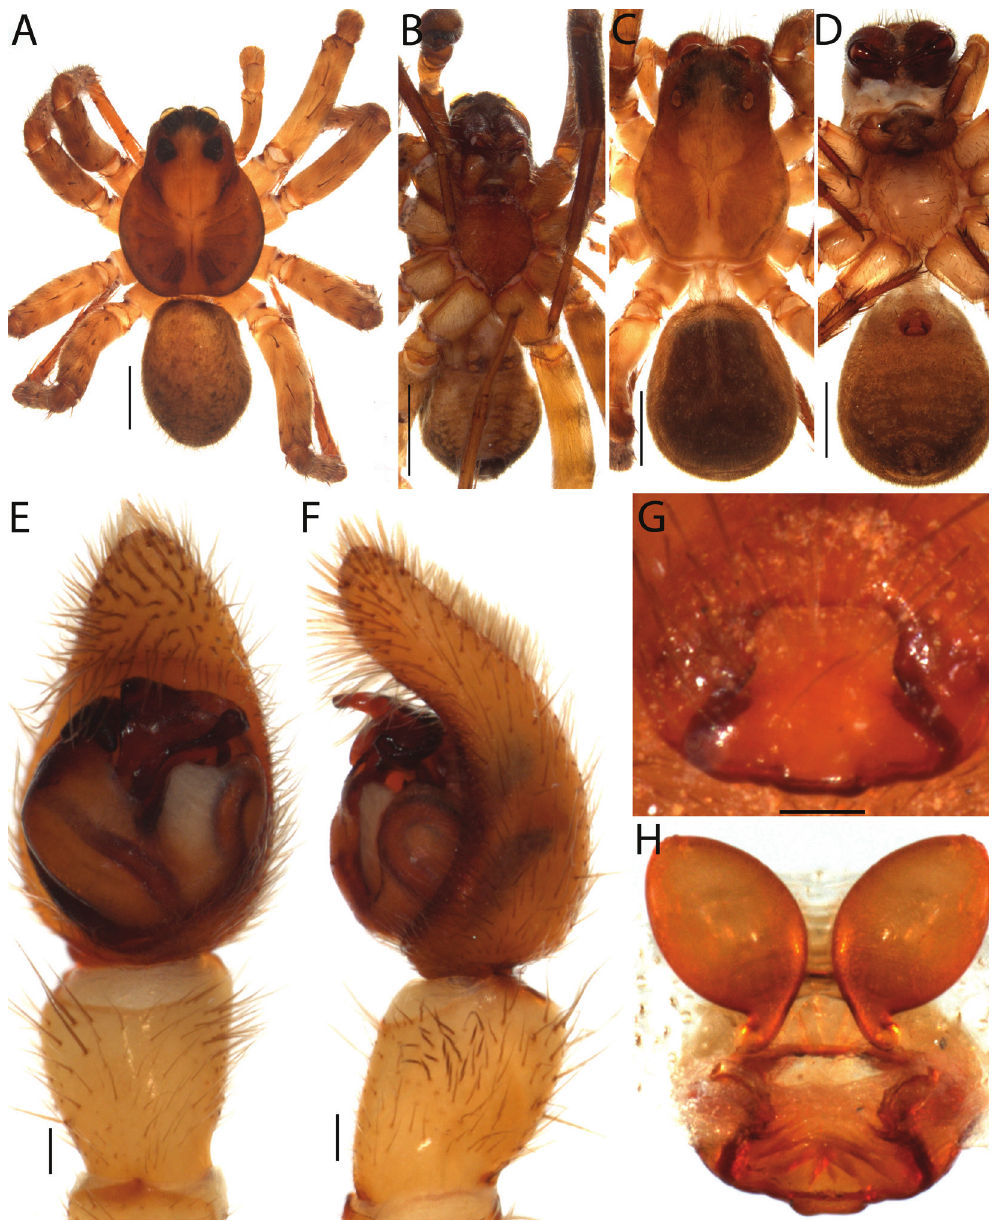
Figure 39. Artoria terania sp. n., male holotype (AM KS10351), female paratype (AM KS85226): A , male habitus, dorsal view; B , male habitus, ventral view; C , female habitus, dorsal view; D , female habitus, ventral view; E, palp, ventral view; F , palp, retro- lateral view; G , epigyne, ventral view; H , epigyne, dorsal view. Scale bars: habitus 1.0 mm; pedipalp, epigyne 0.1